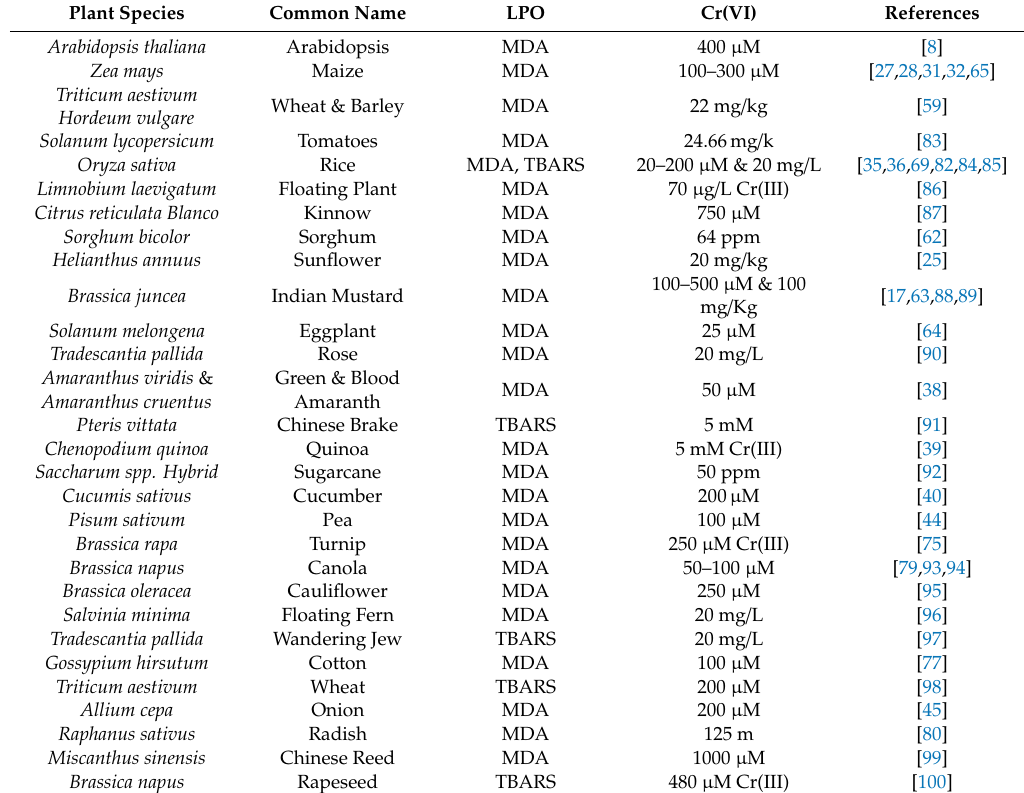
Table 3. Chromium-induced lipid peroxidation indicators in various plant species. Thio-barbituric acid reactive substances (TBARS) and malondialdehyde